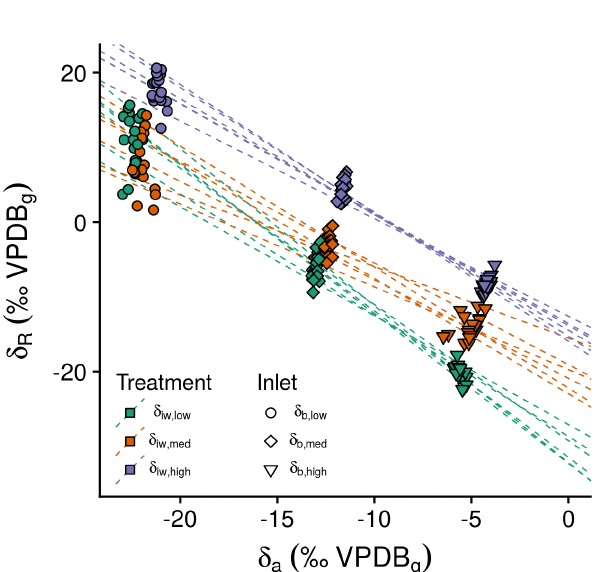
Figure 4. Relationships between the δ 18 O of soil–atmosphere CO 2 exchange ( δ R ) and the δ 18 O of CO 2 in the chamber line ( δ a ) by irri- gation water ( δ iw ) treatment. Symbol shapes indicate measurements made at different inlet conditions ( δ b ) that varied in terms of their δ 18 O of CO 2 . Dashed lines indicate linear regressions for individual